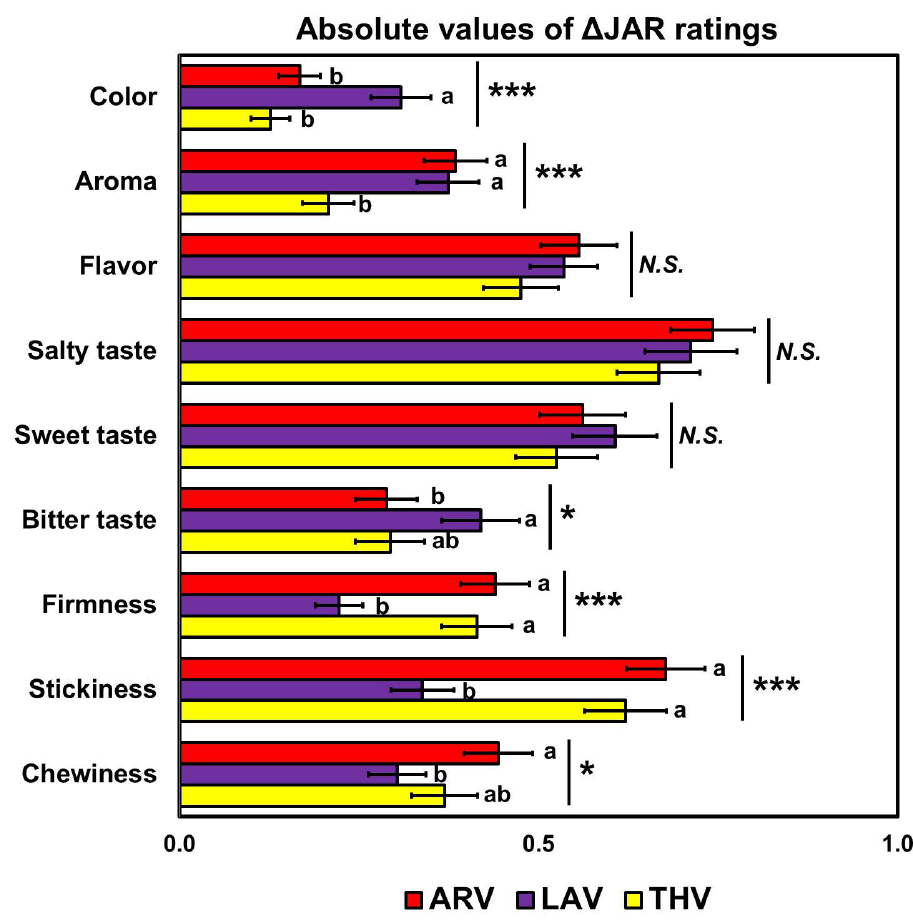
Figure 6. Comparisons among the three cooked aromatic rice samples: ARoma 17 (ARV), Jazzman-2 (LAV), and Thailand Jasmine (THV), with respect to absolute delta of Just-About-Right (JAR) ratings. The absolute delta ( | ∆ | ) JAR scores were computed by subtracting each JAR rating from the JAR value (i.e., 3). * and *** represent a significant di ff erence at p < 0.05 and p < 0.001, respectively. Di ff erent letters with mean ratings within a category indicate a significant di ff erence at p < 0.05. N.S. represents no significant di ff erence at p < 0.05.